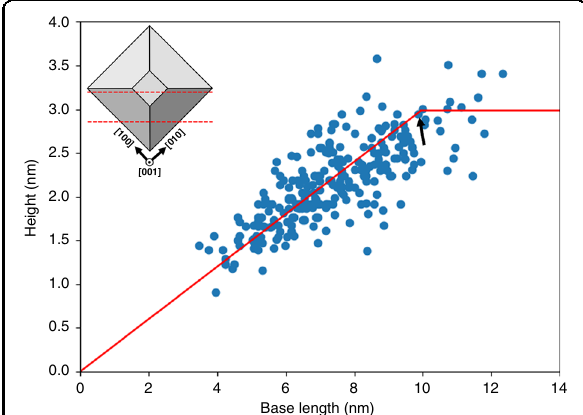
Fig. 2 Height vs base length distribution of 261 individual QDs measured from X-STM images. The red line is a linear fi t to the experimental data (blue). The black arrow indicates the position where the shape of the QDs changes from near triangle to trapezium, with a small top facet. On the left corner, the top view of the most probable QD model is given with dotted red lines, indicating the cleaving planes at two different positions Fig. 3 A 11 × 11 nm 2 fi lled-state image showing one of the